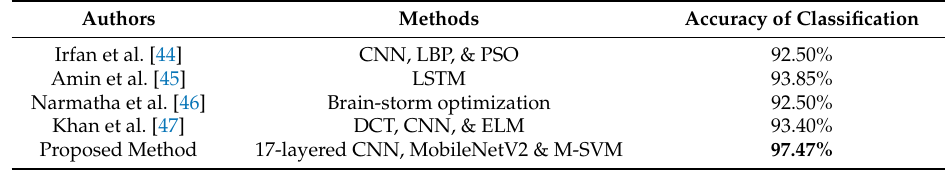
Table 4. Performance comparison with existing